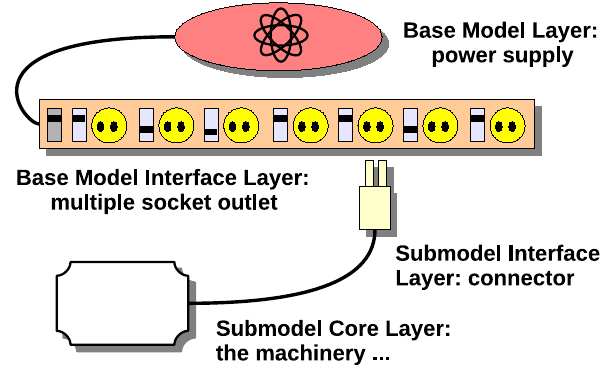
Fig. 1. Sketch of the four layer structure of MESSy.